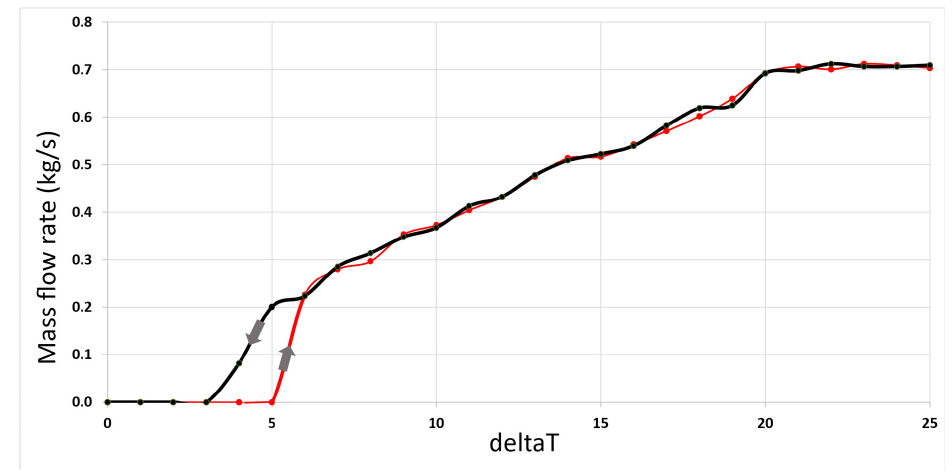
Figure 12. IPC controller characteristic.